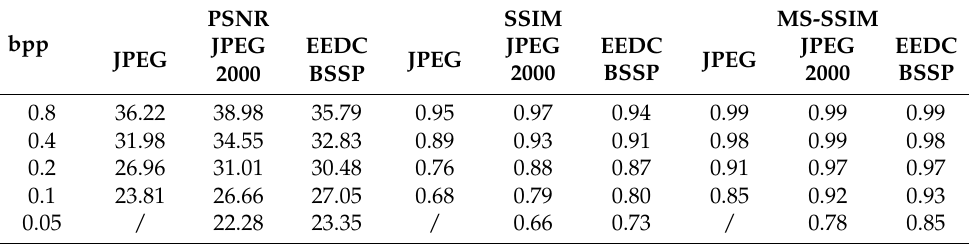
Table 13. Results of the PSNR, SSIM, and MS-SSIM metrics for image beauty .